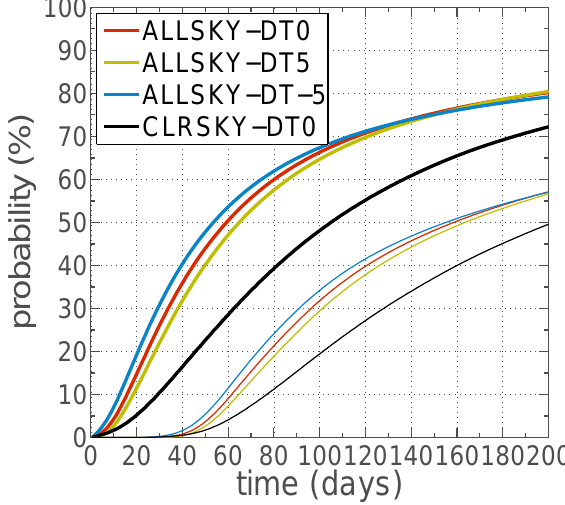
Fig. 3. Cumulative proportion of CS-TTL trajectories plotted as a function of time for transport of air between convective sources and the 100hPa (thick lines) and 70hPa (thin lines) surfaces. Results obtained from back trajectories, calculated in both clear-sky and all-sky conditions where different thermal biases were taken into account (see text for more details). The trajectories were launched between the beginning of 2005 and the middle of 2006, with cloud encounters restricted to